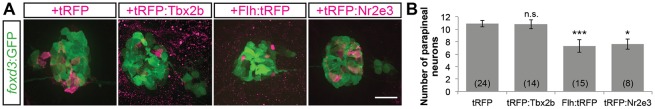
Mosaic overexpression of Tbx2b does not induce additional parapineal neurons; mosaic overexpression of Flh or Nr2e3 suppresses the number of parapineal neurons. (A) Representative images of 2 dpf antibody-labeled pineal complexes (foxd3:GFP+) with the indicated protein mosaically overexpressed. Scale bar: 30 µm. (B) Quantification of the number of parapineal neurons in Tg[foxd3:GFP] zf10; Tg[cfos:gal4vp16]s1145t double transgenic embryos injected with pDestTol2CG2(4nrUAS:tagRFP-T:polyA) (tRFP), pDestTol2CG2(4nrUAS:tagRFP-T:tbx2b) (tRFP:Tbx2b), pDestTol2CG2(4nrUAS:flh:tagRFP-T) (Flh:tRFP), or pDestTol2CG2(4nrUAS:tagRFP-T:nr2e3) (tRFP:Nr2e3); mean±s.e.m. and number of samples (n) are shown. ***P <0.001, *P<0.05, P>0.05 (n.s.), one-way ANOVA with Dunnett's post-hoc analysis, comparisons with tRFP shown.